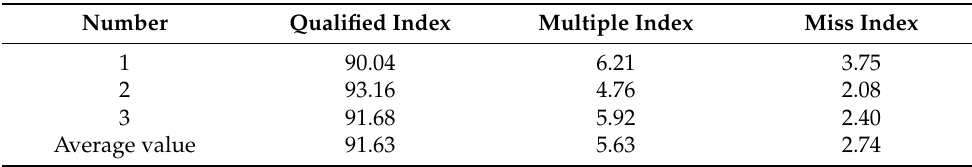
Table 7. Results of the verification